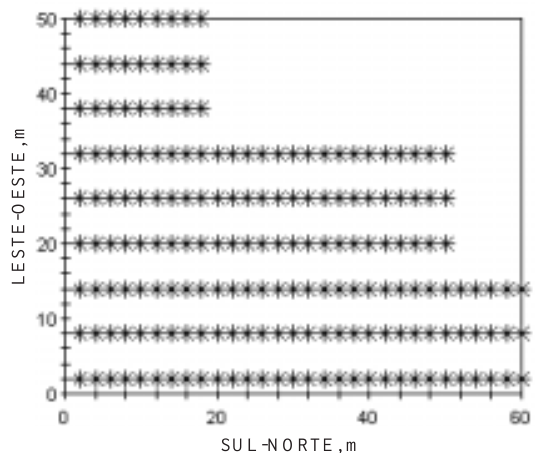
Figura 1. Área do experimento com o local de coleta das amostras de solo. (Asteriscos indicam os pontos